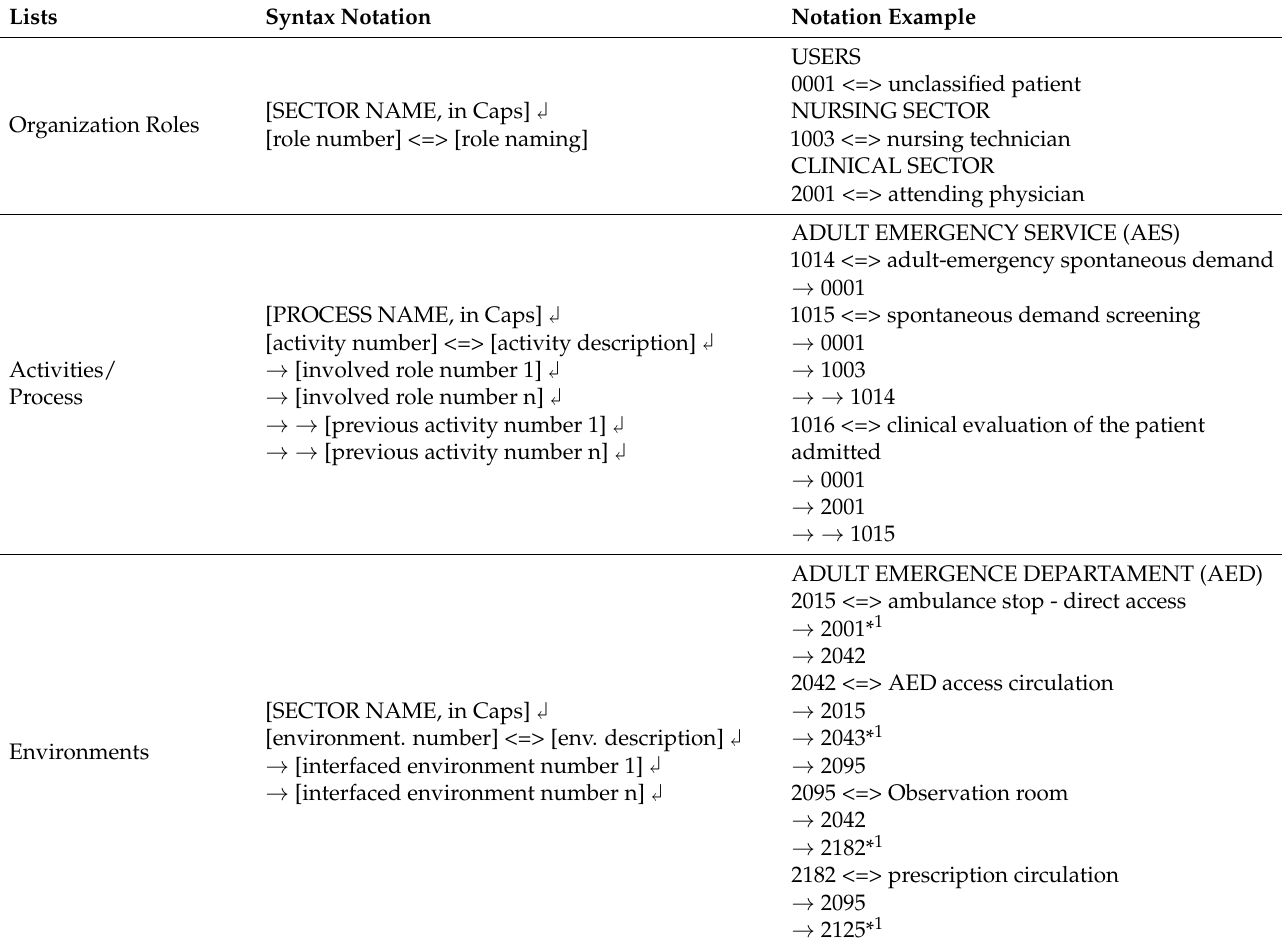
Figure 1. Example of the in-person interview records. ( a ) Plan of the first floor; ( b ) laundry services activity list (translated notes). Table 4. Syntactic structure of notation developed for MC-MS